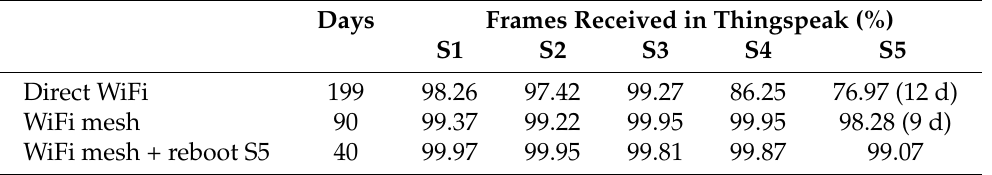
Table 4. Percentage of frames received by the Thingspeak platform from the nodes (S1–S5) of the WASN. The first row corresponds to the percentages obtained with a direct connection between the nodes and the cores. The second row depicts the values with the mesh connection and the third row shows the percentages achieved when a weekly reboot of S5 was programmed. The values in parentheses correspond to the number of days sensor S5 sent data before losing the